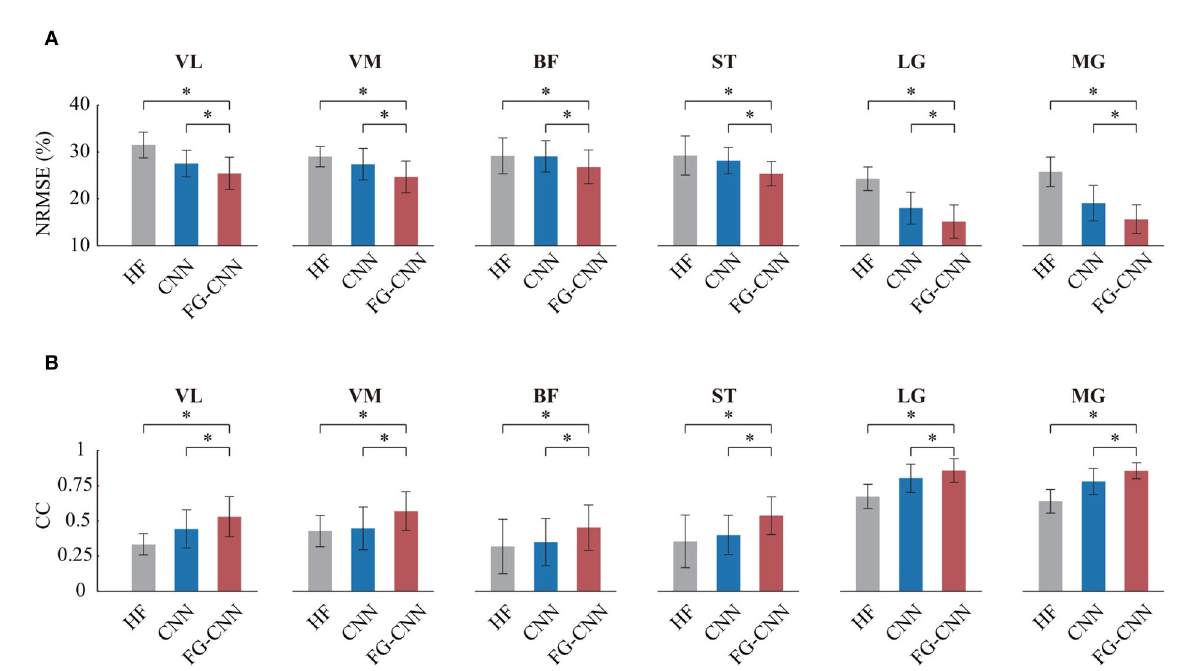
FIGURE5 Comparison of angle estimation accuracy by HF, CNN, and FG-CNN. (A) Comparison of NRMSE. (B) Comparison of CC. Bars are means, error bars are standard error of the mean (SEM), and asterisks denote statistical significance ( P < 0.05).